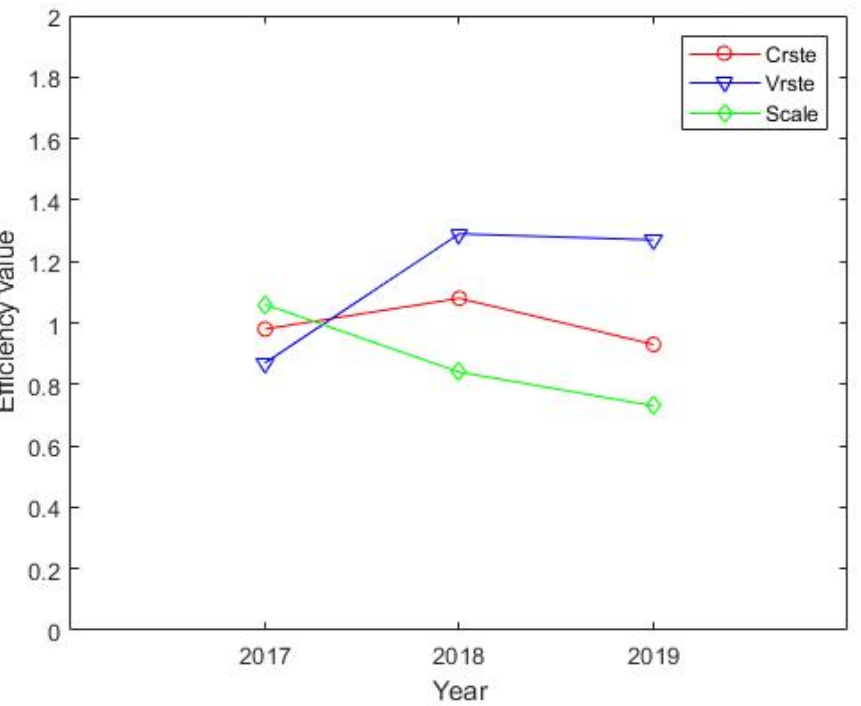
Figure 6. Efficiency and decomposition of China’s carbon trading market.